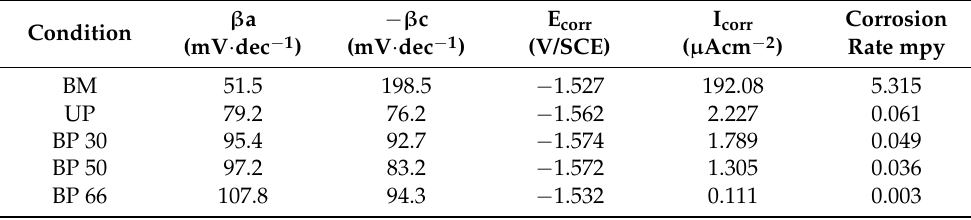
Figure 8. Corrosion measurement curves of AM60 alloy processed through ECAP: ( a ) open circuit potential, ( b ) poten- tiodynamic polarization curves, ( c ) cyclic potentiodynamic polarization, ( d ) Nyquist plot, ( e ) electrochemical impedance diagrams (Bode plot), and ( f ) phase angle. Table 3. Electrochemical parameters: corrosion potential (Ecorr), corrosion current density (Icorr), and anodic (b a ) and cathodic (b c ) slopes obtained from the Tafel extrapolation